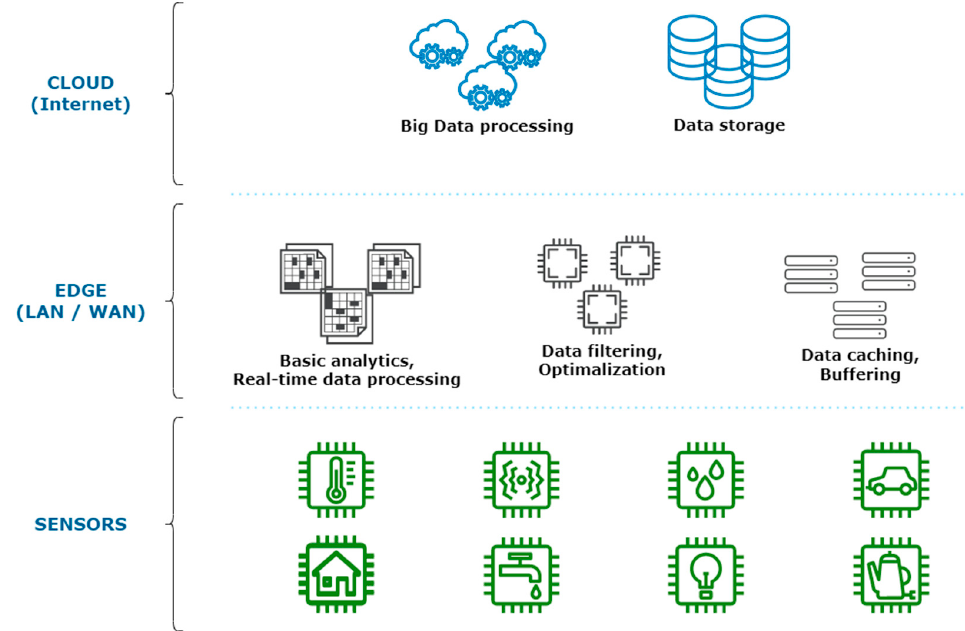
Figure 4. IoT architecture for smart grid.